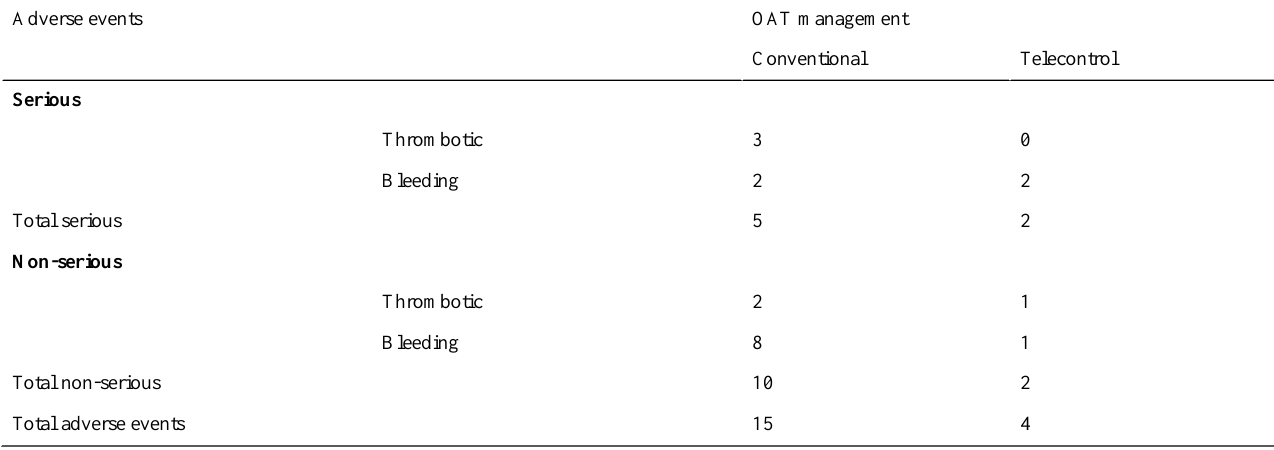
Table 4. Distribution of thrombotic and bleeding events in the two groups of oral anticoagulant therapy (OAT) management groups (conventional control and telecontrol with the SintromacWeb system), according to